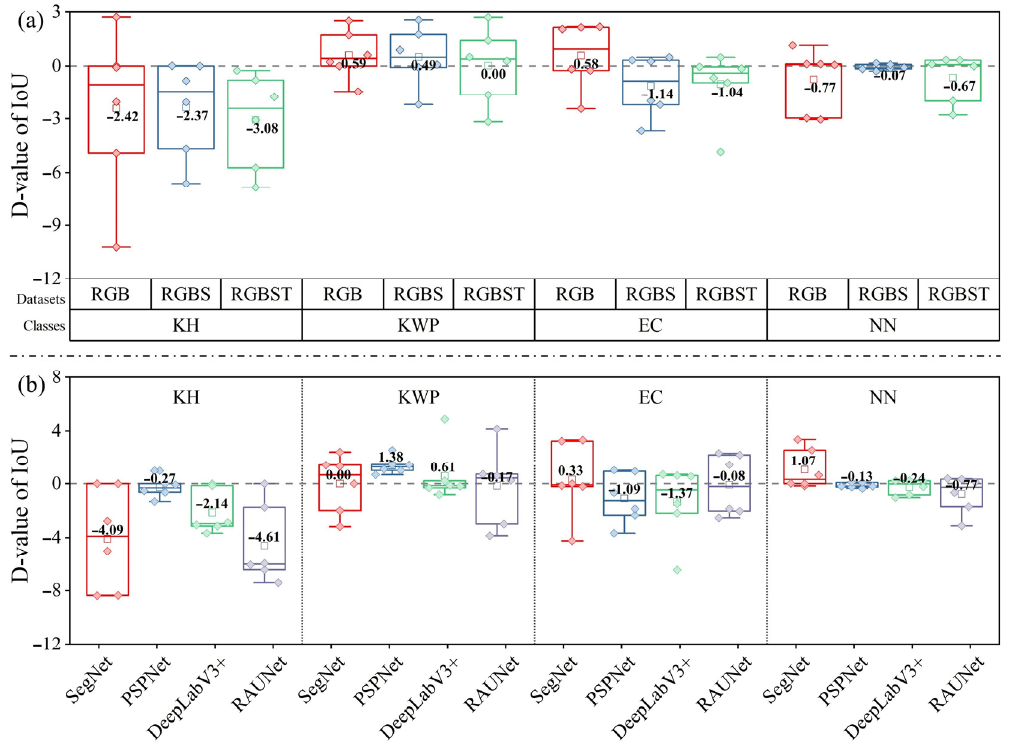
Figure 22. Difference between the IoU of model fusion for each karst wetland vegetation and the highest IoU before fusion. ( a ) FCMs based on different image datasets and ( b ) FCMs based on different CNN algorithms.